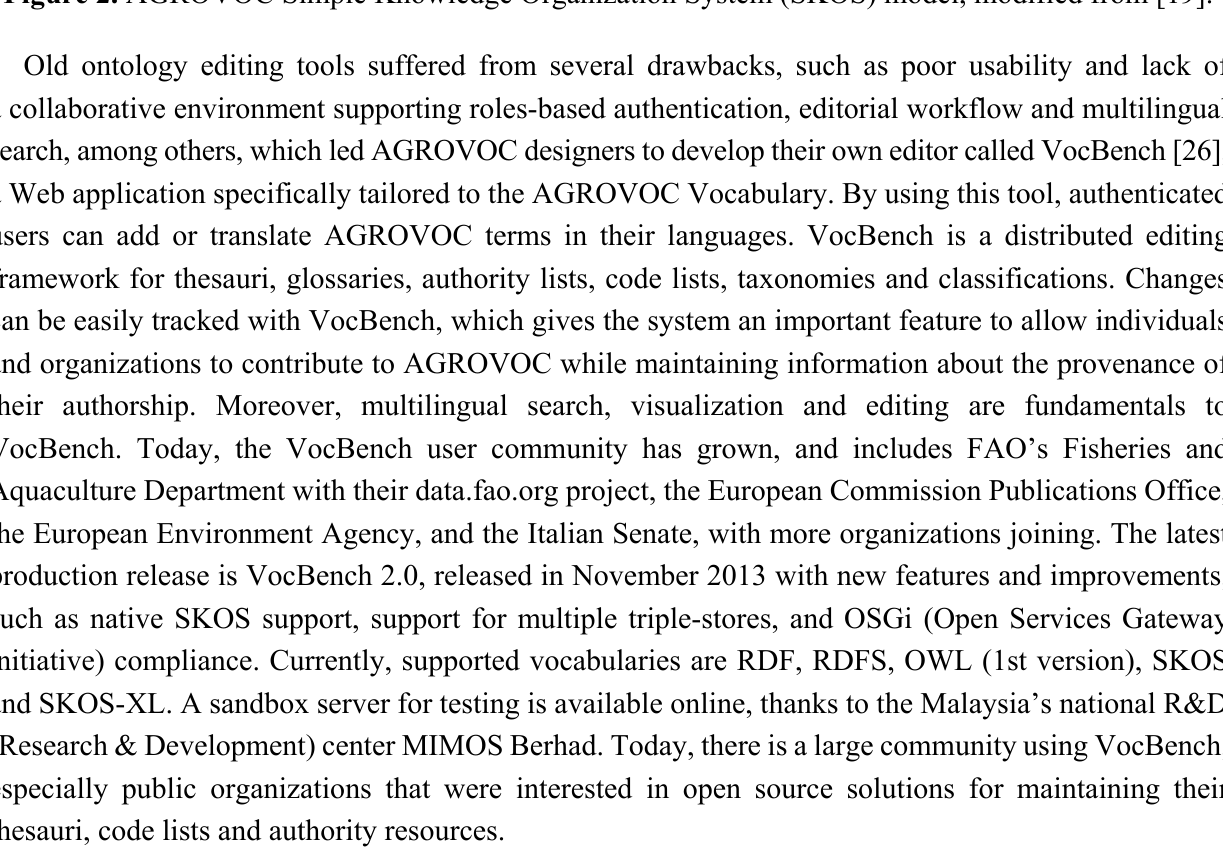
Figure 2. AGROVOC Simple Knowledge Organization System (SKOS) model, modified from